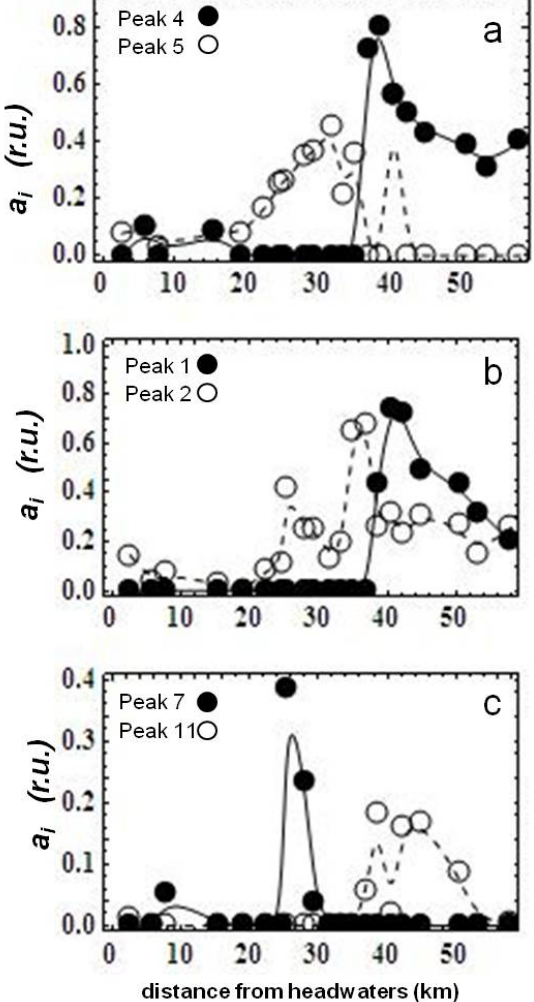
Fig. 8. Intensity of several peaks (in Raman units) detected along the la Tordera river. Solid and dotted lines show the smoothed trend of each peak. Lines are obtained with a cubic B-spline function and have only a descriptive purpose.